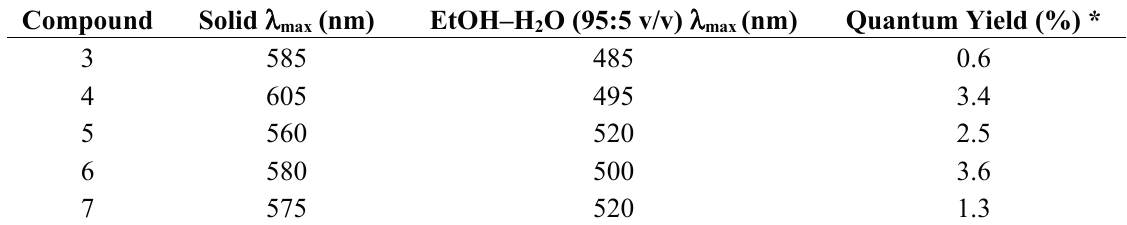
Table 2. Comparison of fluorescence emission maxima in the solid state and EtOH–H (95:5 v/v) for compounds ( 3 – 7 ) together with calculated quantum yields in the EtOH–H (95:5 v/v) solution compared to standard quinine sulfate in 0.1 M sulfuric